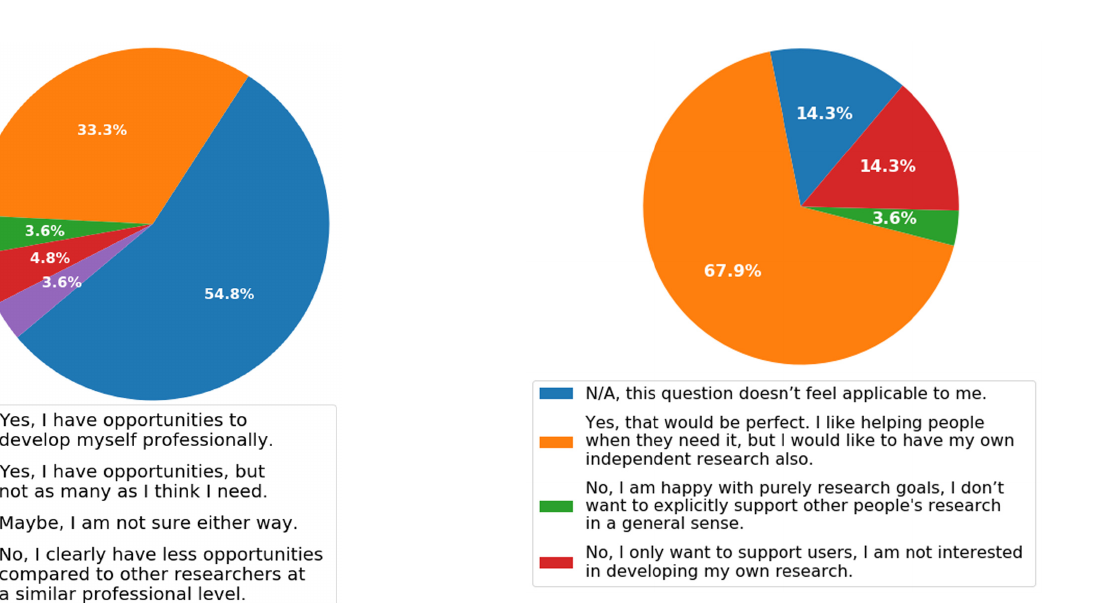
Figure 14. Pie chart representing the answers to Q2.10. Participants were able to select only one answer. Data was pooled from across job descriptions for this